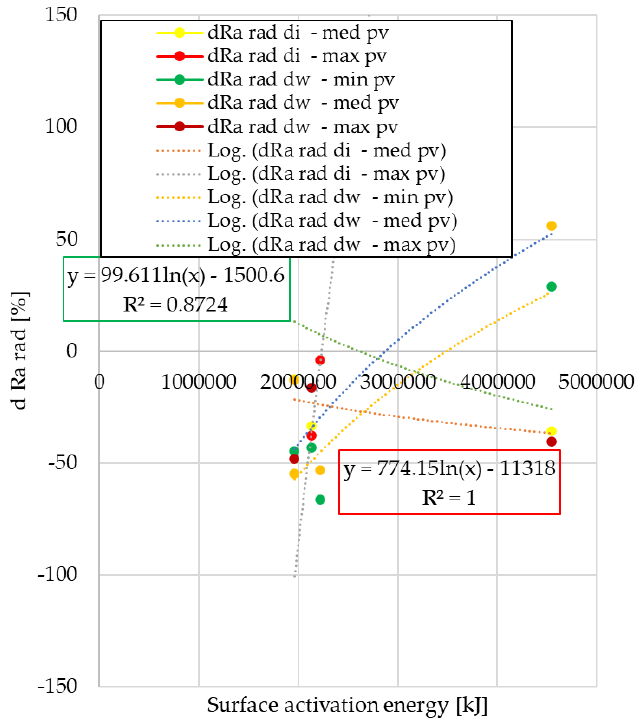
Figure 14. Variation of radial Ra values after pin-on-disk as a function of surface activation energy — normal use facings. Of clutch killer trend facing samples, the trends in roughness variation due to differ- ent pv levels follow three different types of functions: the results for internal diameter specimens are described by linear and quadratic equations, and the post-pin-on-disk val- ues for specimens cut from friction diameter are described by linear and logarithmic equa- tions. Additionally, for normal use facings, results show a strong pv -dependence with lin- ear and logarithmic trends. 4. Dry Friction Hybrid Composite Tribological Behavior Investigation Results Use The simulation model is capable of taking effects of wear into account. One direction for further development could be the parameterized automation of wear by creating sim- ulations with arbitrary wear intensities. Another application of the model highlights the oversized state of currently used conventional vehicle clutches, i.e., their cost reduction potential. The currently used sizing procedures consider the friction coefficient as a constant value up to a certain temperature level, without taking into account the pv -dependence. Figure 15 illustrates that heat loads calculated with real, pv -dependent COF values result in lower temperatures, so that the currently used calculation methods oversize the pressure plate, for example.